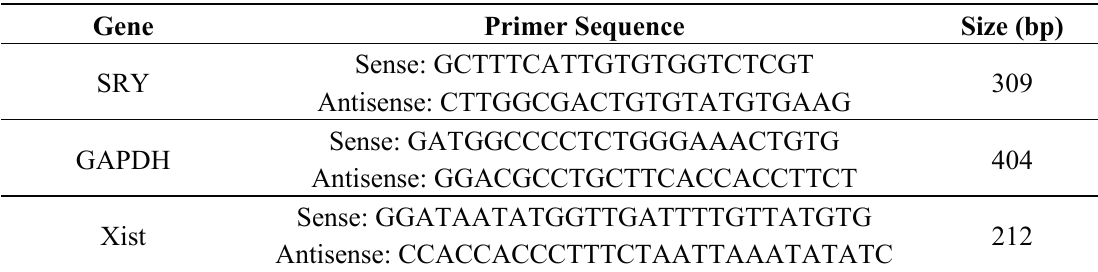
Table 2. Primer sequences for reverse transcription PCR (RT-PCR).